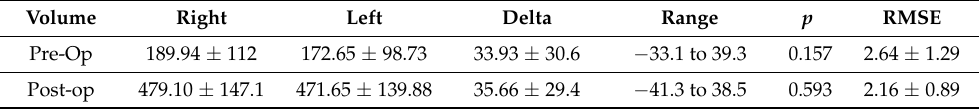
Table 3. Digital breast symmetry assessment.